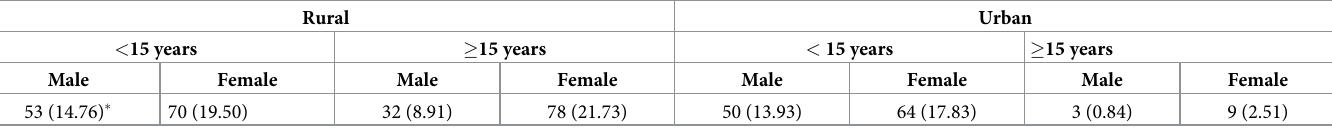
Table 1. Patient demographics.